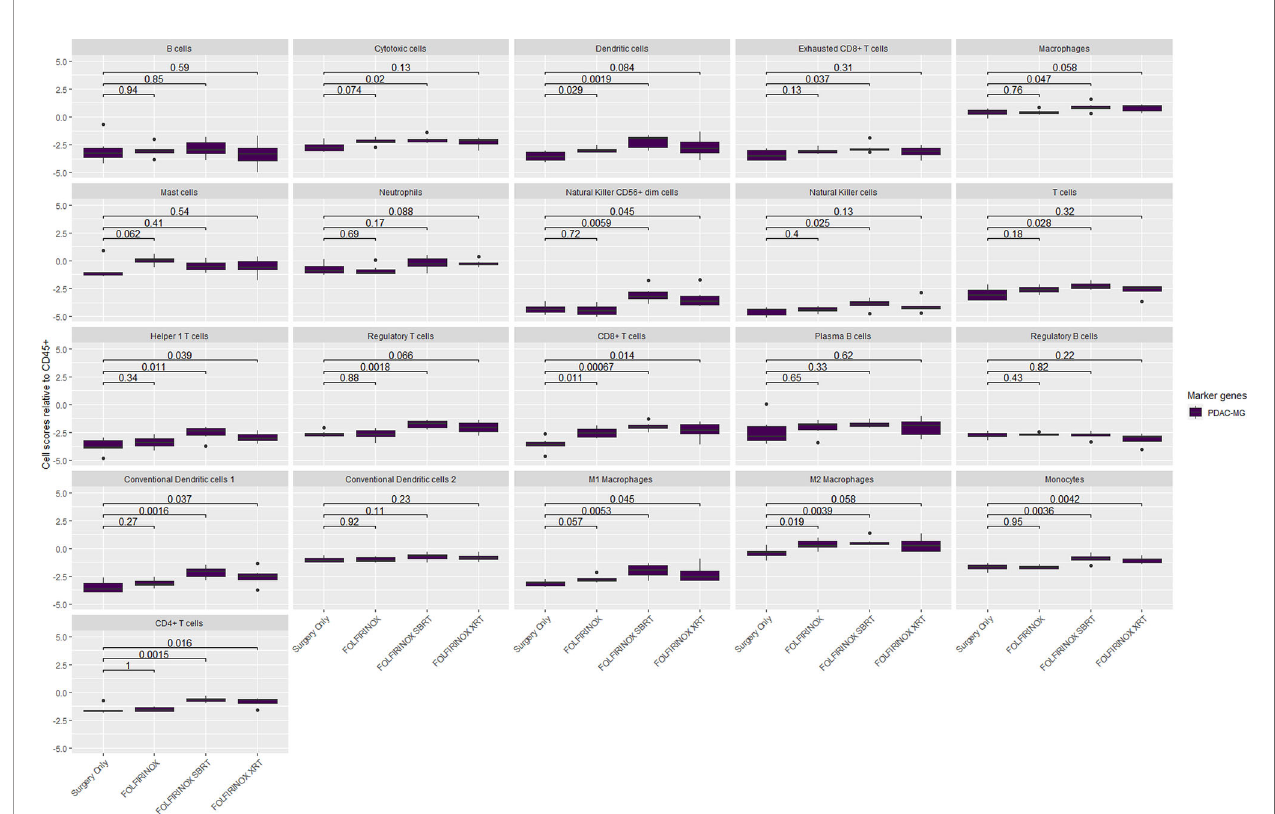
FIGURE 5 | The relative immune abundance in PDAC tissue samples that received neoadjuvant therapy compared to treatment naïve samples using PDAC-MGICs. Comparing the relative immune scores using mRNA expression data of 18 PDAC tissue samples of patients who receive three types of neoadjuvant therapy compared to patients who were subjected to surgery before receiving any treatment (Surgery Only). Immune cells were identi fi ed using the PDAC-GMICs set and were presented relative to the total in fi ltration of CD45+ expression. The treatment effect of FOLFIRINOX + SBRT treated samples is most apparent. The p -values are the result of two-sided t-tests between Surgery Only and the other treatment groups individually. Surgery only (purple); neoadjuvant FOLFIRINOX (blue), FOLFIRINOX + SBRT (green), FOLFIRINOX + XRT